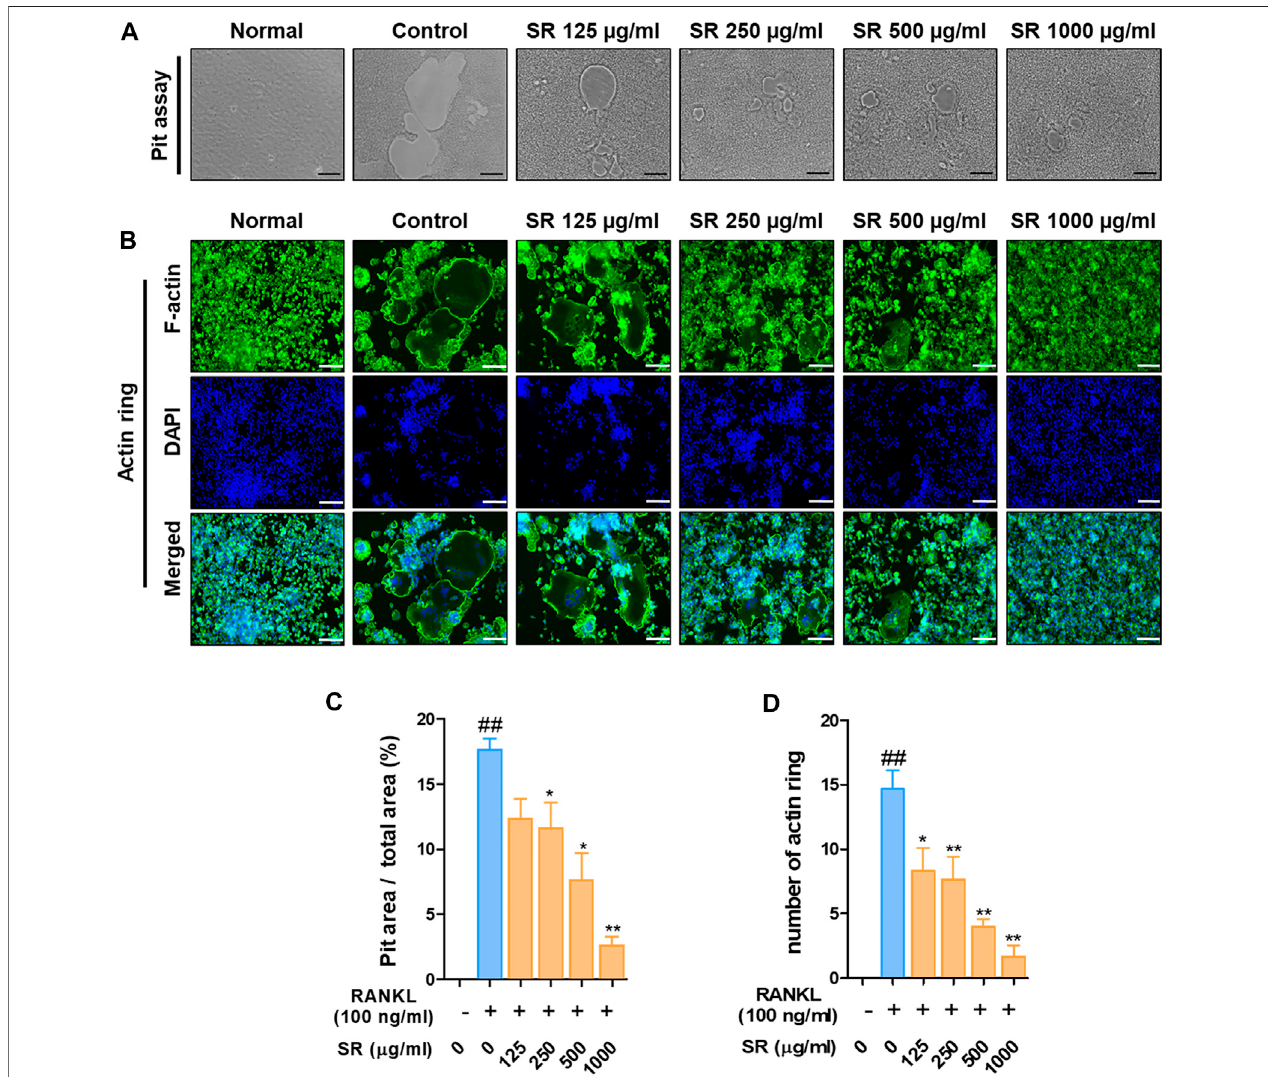
FIGURE 2 | The effects of SR on bone resorption and F-actin ring formation in RANKL-induced RAW 264.7 cells. (A) Pit formation was captured using an inverted microscope(magni fi cation, × 100;scalebar,200 µm). (B) F-actinrings werestainedwith fl uorescentphalloidin (magni fi cation, × 100;scalebar,200 µm). (C) Thepitarea was measured using ImageJ software. Data are presented as the mean ± SD (standard error of the mean) of three independent experiments. (D) The number of F-actin ringswascounted.Dataarepresentedasthemean ± SDofthreeindependentexperiments.Statisticalanalysiswasperformedusingone-wayANOVAfollowedby Dunnett ’ s post hoc test. ## p < 0.01 vs. the normal group (untreated cells); * p < 0.05, ** p < 0.01 vs. the RANKL only treatment group.